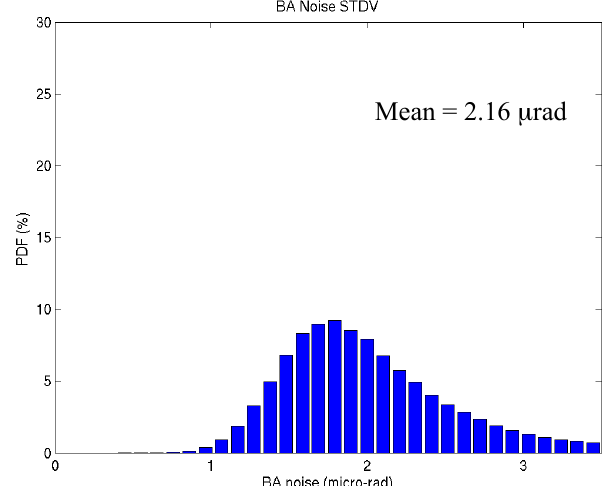
Fig. 16. Distribution of standard deviation of bending angle noise for ∼ 146000 F3C profiles that used clock reference satellite data acquired on the opposite side of the F3C satellite as the occulting satellite